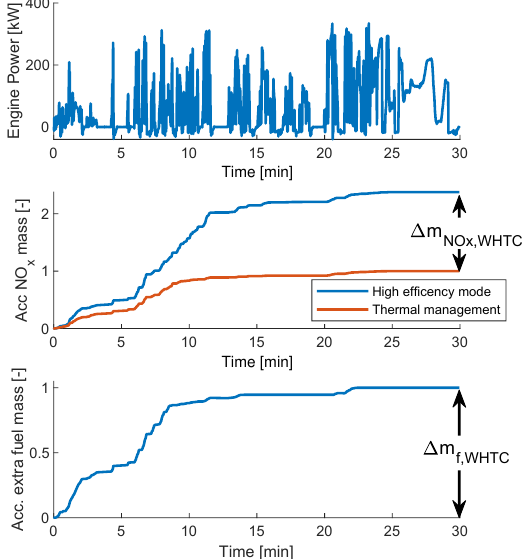
Figure 5. Illustration of the masses used in the equivalence relation between fuel and NO x . The data are from a simulation of the WHTC using the baseline strategy. The units for fuel and NO x are normalized so that the extra fuel mass and accumulated NO x mass when using the baseline strategy both end at one. The normalized units are called the normalized fuel unit (NFU) and normalized NO x unit